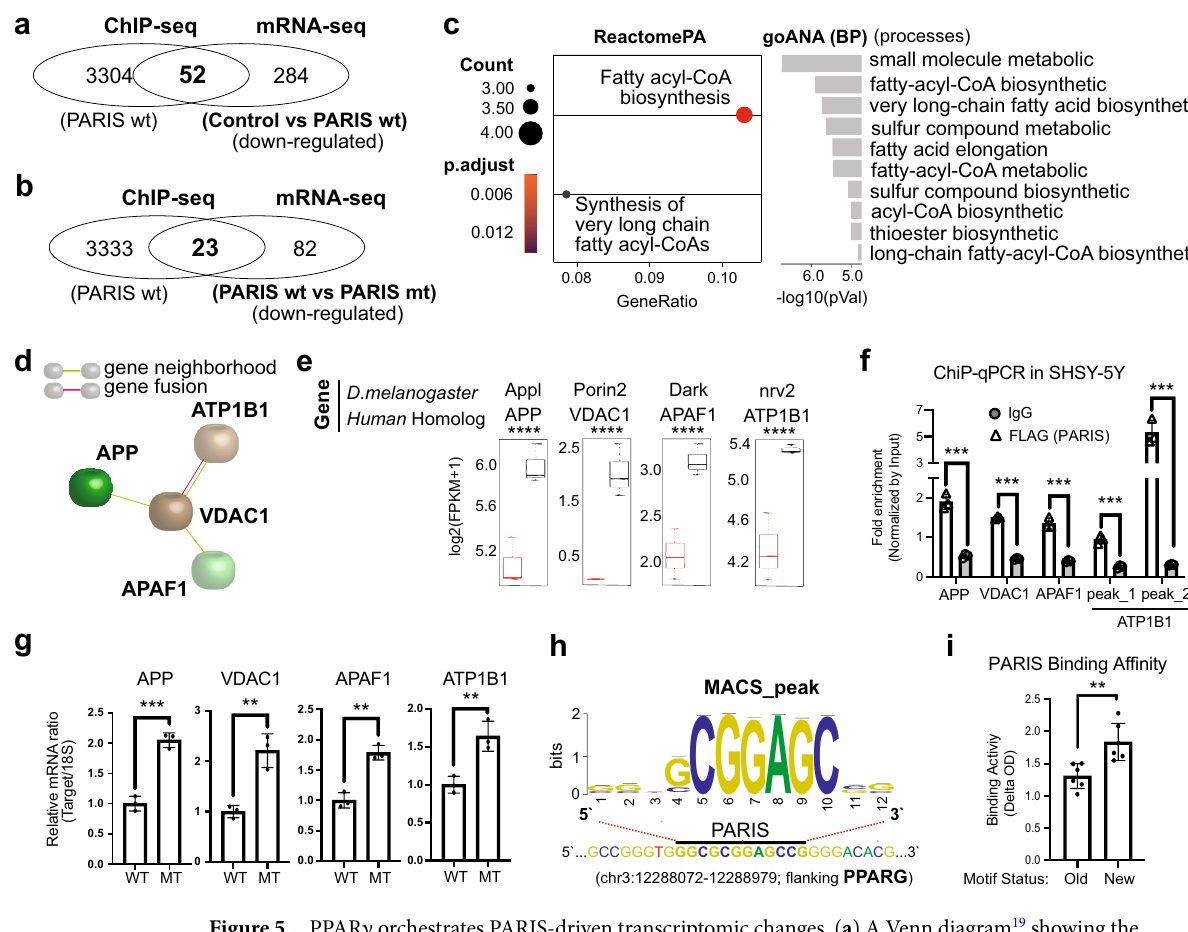
Figure 5 . PPARγ orchestrates PARIS-driven transcriptomic changes. ( a ) A Venn diagram 19 showing the shared genes between human orthologs of the DEGs identified as downregulated from “TRAP control versus PARIS wild type” comparison (TRAP-seq) and the entire set of the peak-annotated genes (ChIP-seq). ( b ) A Venn diagram 19 showing the shared genes between human orthologs of the DEGs identified as downregulated from “PARIS C571A mutant versus PARIS wild type” comparison (TRAP-seq) and the entire set of the peak- annotated genes (ChIP-seq). ( c ) Ontology- and pathway-level enrichment results of the genes specified in ( a ). PPARγ-related GO terms are significantly enriched. ( d - e ) The STRING PPI network 28 results of the shared genes specified in ( b ) and the expression profiles of the genes in this network. *** p ≤ 0.001, **** p ≤ 0.0001. The shared 23 DEGs successfully reproduced a part of the PPARγ network in Fig. 3a. FET p value threshold: 1e−03. Minimal Interaction Score: 0.400. Colored nodes: query genes (or proteins) and first shell of interactors. ( f - g ) ChIP-qPCR and RT-qPCR validation results of the target genes in ( d ). Both of the two distinct peaks associated with ATP1A1 gene were experimentally validated, together with the rest of the target genes. Statistical significances were analyzed with GraphPad Prism V7 software using Student’s unpaired t test. P v alues lower than 0.05 were considered significant. All qPCR-based expression data presented here were expressed as mean ± standard deviation values, for each condition studied. ( h ) PPARγ promoter region contains binding motif for PARIS. The k-mer significance = 123.19, the e-value = 6.5e−124, the number of genomic sites containing the motif = 4484. ( i ) The results of the colorimetric measurements that compare the binding affinities of PARIS to different motif sequences. PARIS has a significantly higher binding affinity to the new motif sequence identified within the scope of this study. ** p ≤